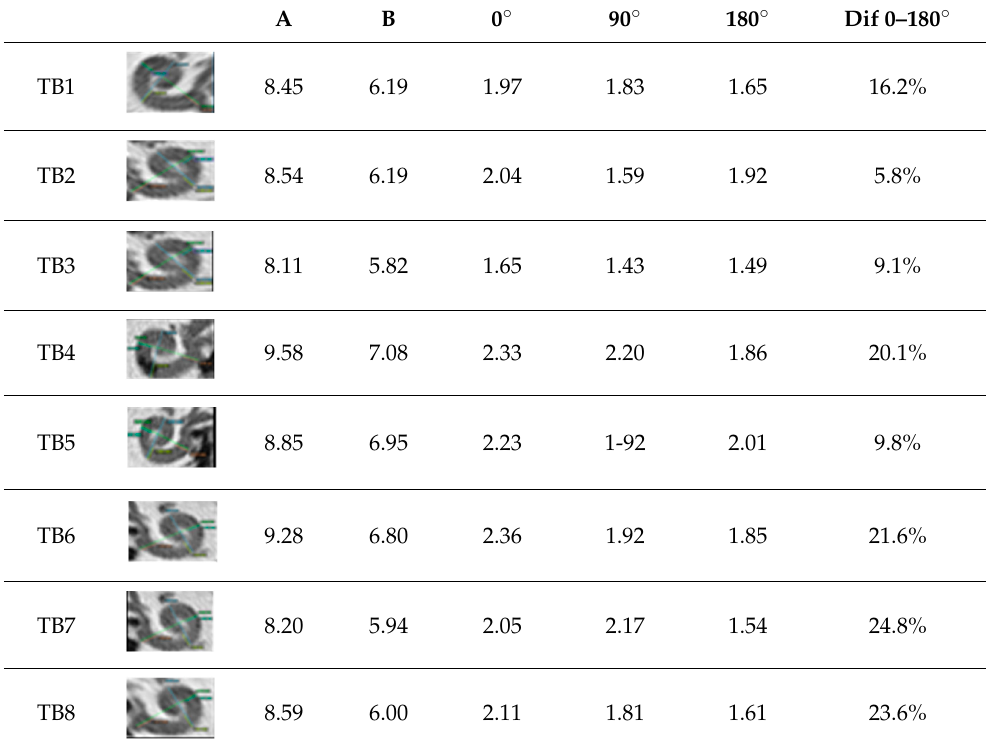
Table 1. Dimensions of temporal bones (TB). Column A: diameter from round window to the external wall passing through the modiolar area; Column B perpendicular to the previous. The cochlear duct diameter was measured at 0 ◦ , 90 ◦ , and 180 ◦ .